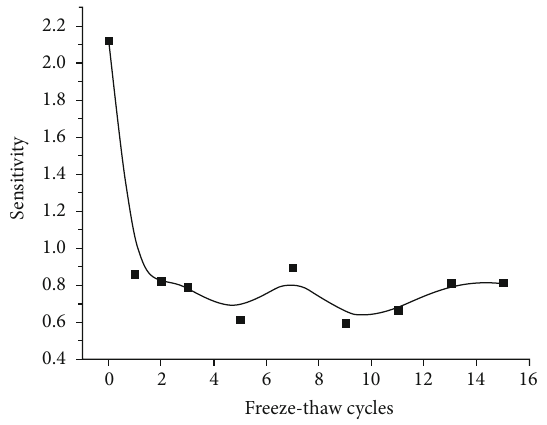
Figure 3: Variation of sensitivity under di ff erent freeze-thaw